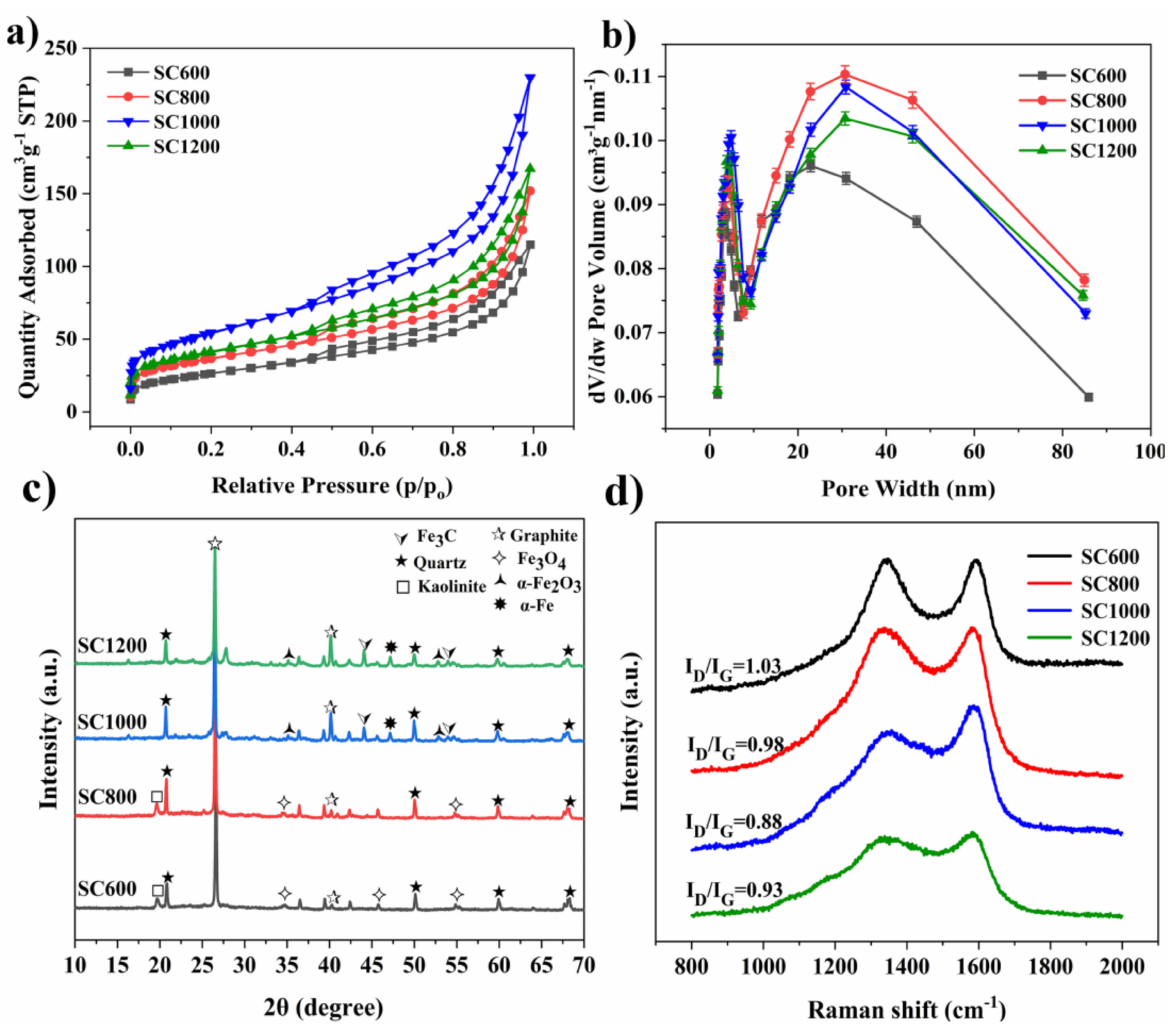
Figure 3. ( a ) N 2 adsorption-desorption isotherms, ( b ) pore size distribution, ( c ) powder XRD patterns and ( d ) Raman spectra of the SC